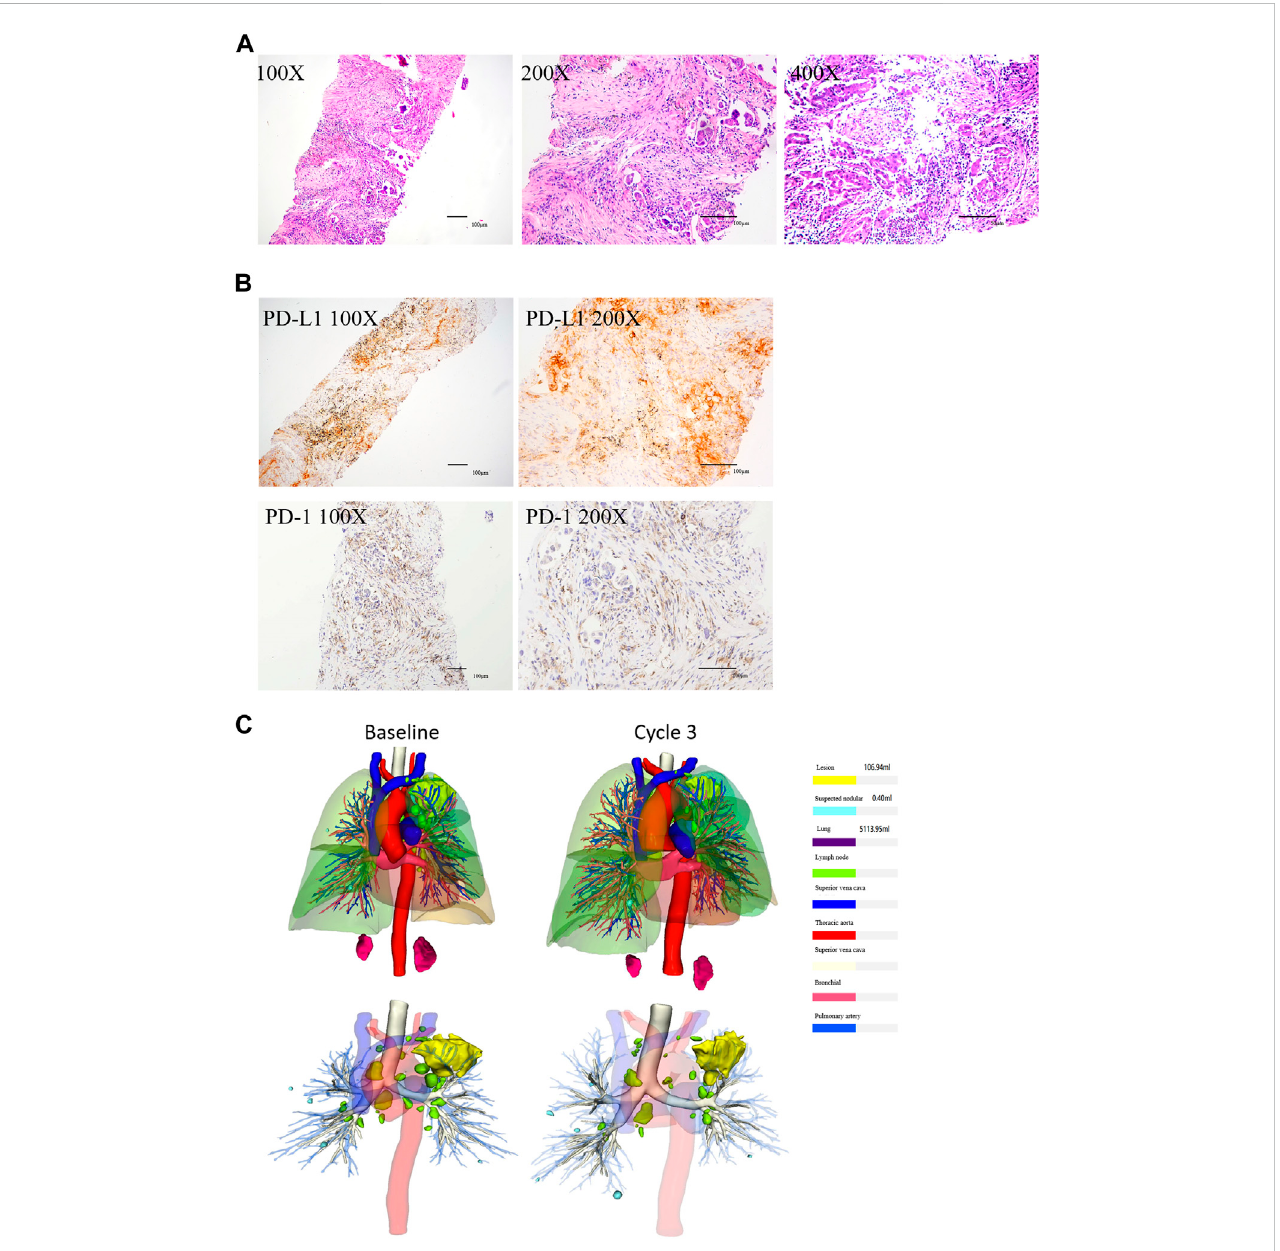
FIGURE 2 HE and IHC of NSCLC tissues, and the three-dimensional reconstruction of tumor. (A) HE showed that the tissues were moderately and poorly differentiated adenocarcinoma (From left to right: ×100 magni fi cation, ×200 magni fi cation, and ×400 magni fi cation). (B) IHC showed that the expression of PD-L1 and PD-1 were positive (Left: ×100 magni fi cation, right: ×200 magni fi cation). (C) Three-dimensional reconstruction showed that the tumor shrinked after the third cycle.